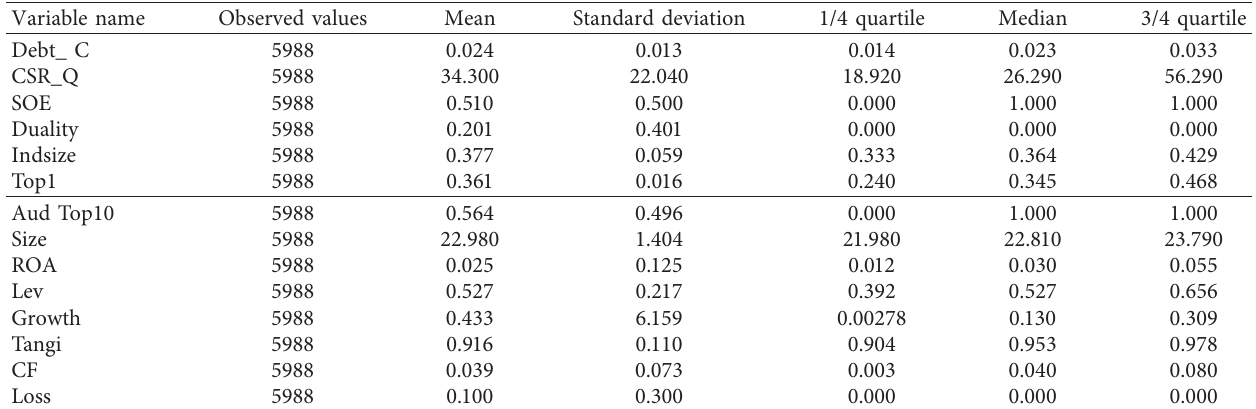
Table 2: Descriptive statistics of